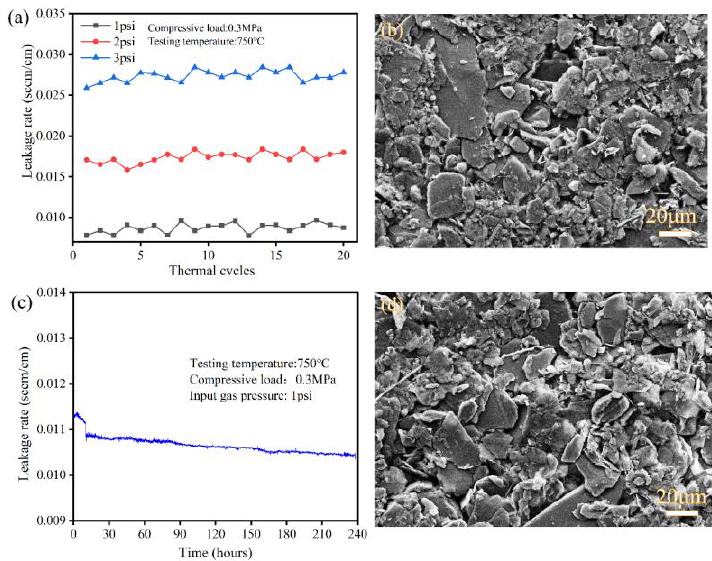
Figure 5. The leakage rates of vermiculite seals over 20 thermal cycles ( a ) and long-term operation ( b ) under a compressive load of 0.3 MPa and input gas pressure of 1 psi to 3 psi at 750 °C; and the SEM micrograph after 20 thermal cycles ( c ) and long-term operation ( d ).